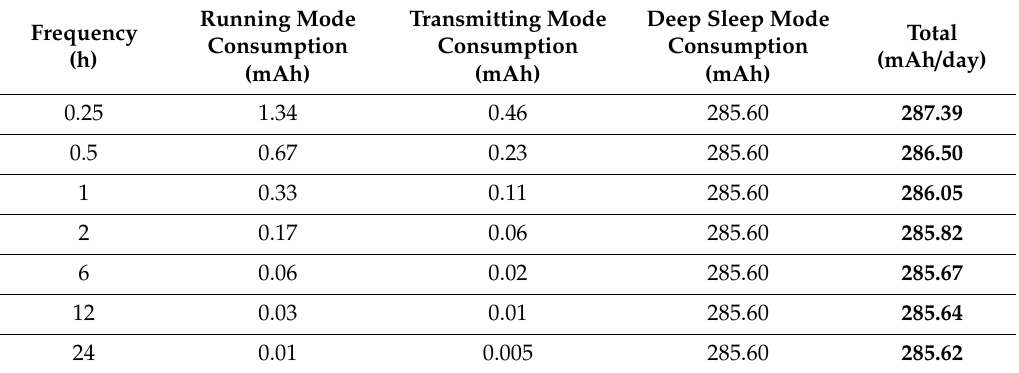
Table 4. Daily energy consumption according to measurement frequency for each function mode.